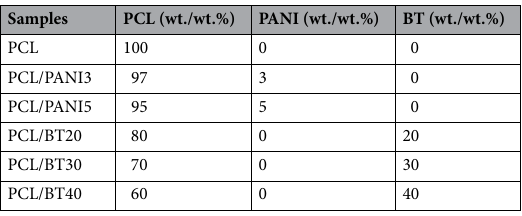
Table 1. Composition of electrospun PCL, PCL/PANI and PCL/BT.